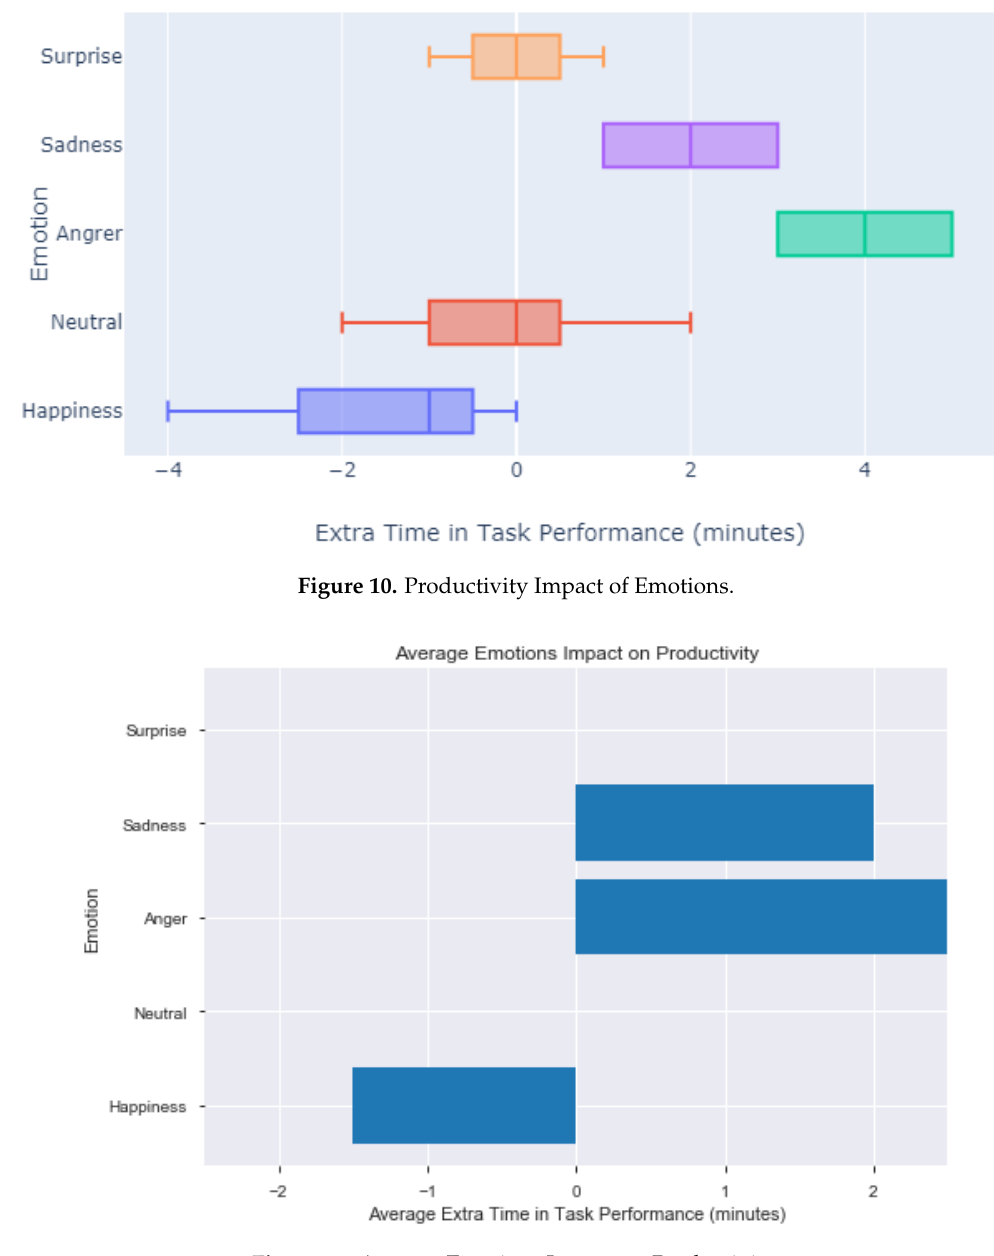
Figure 11. Average Emotions Impact on